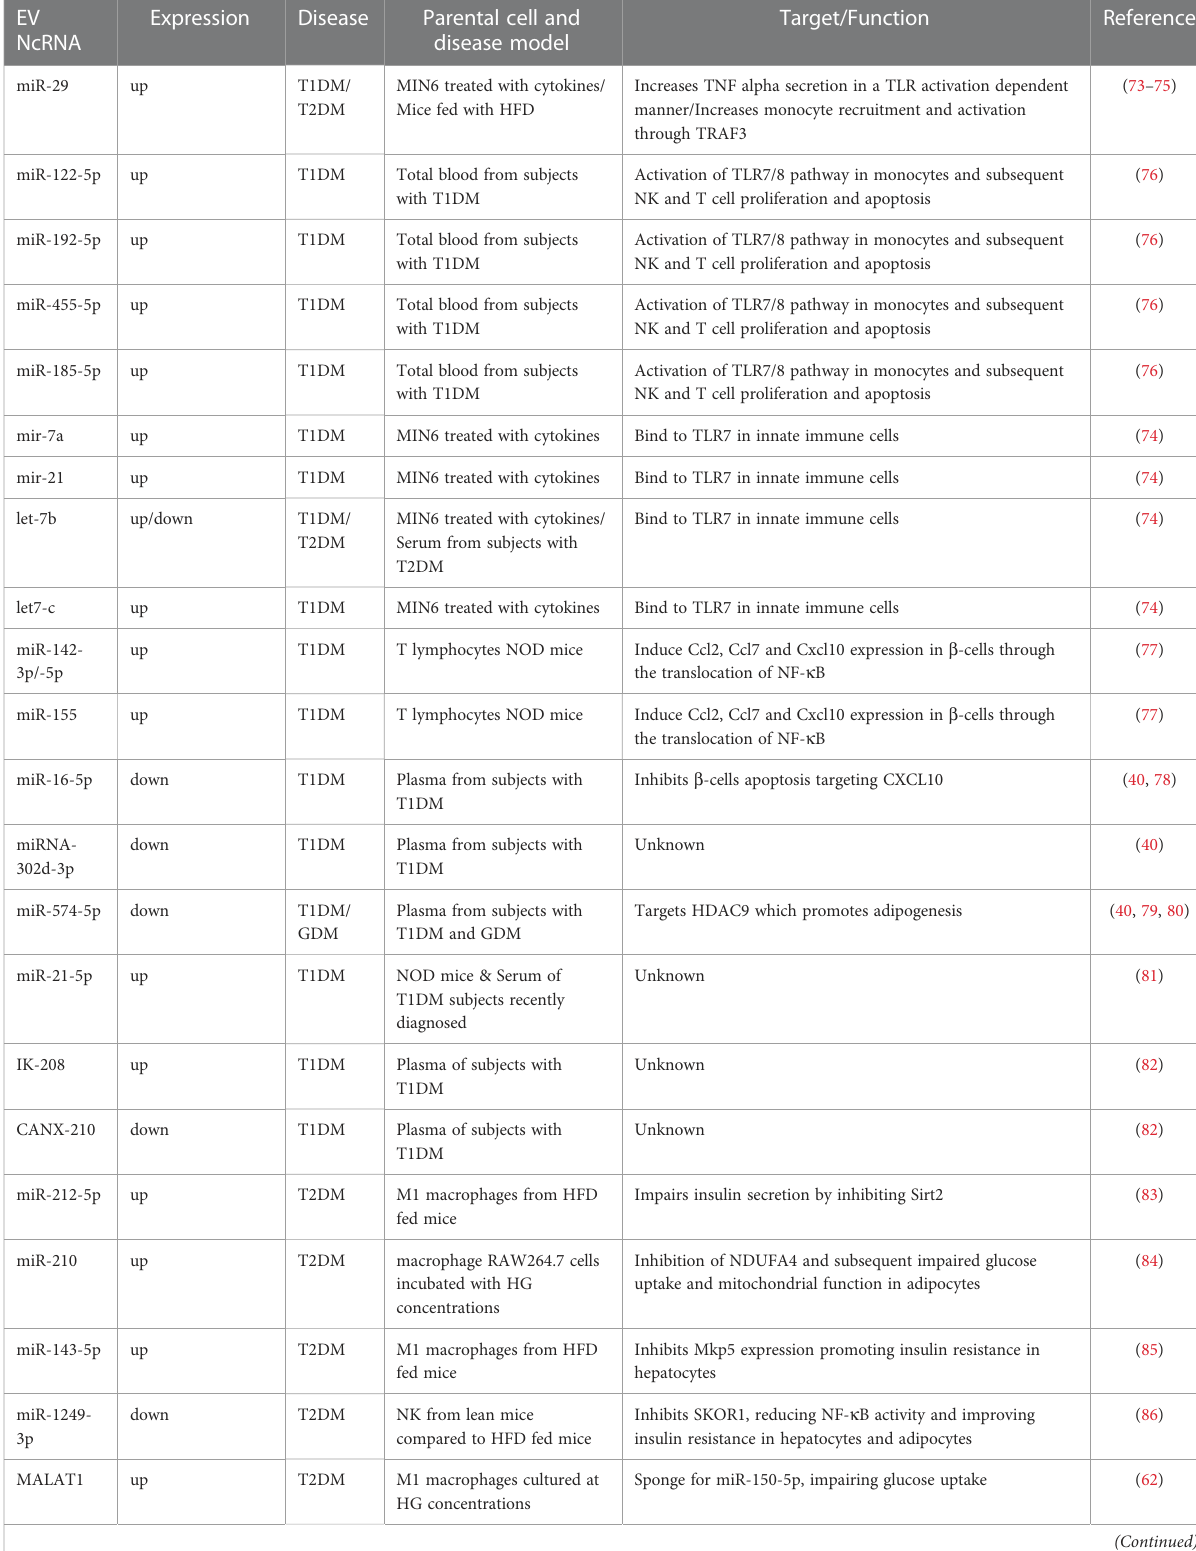
TABLE 1 EV associated ncRNAs dysregulated in different forms of diabetes.